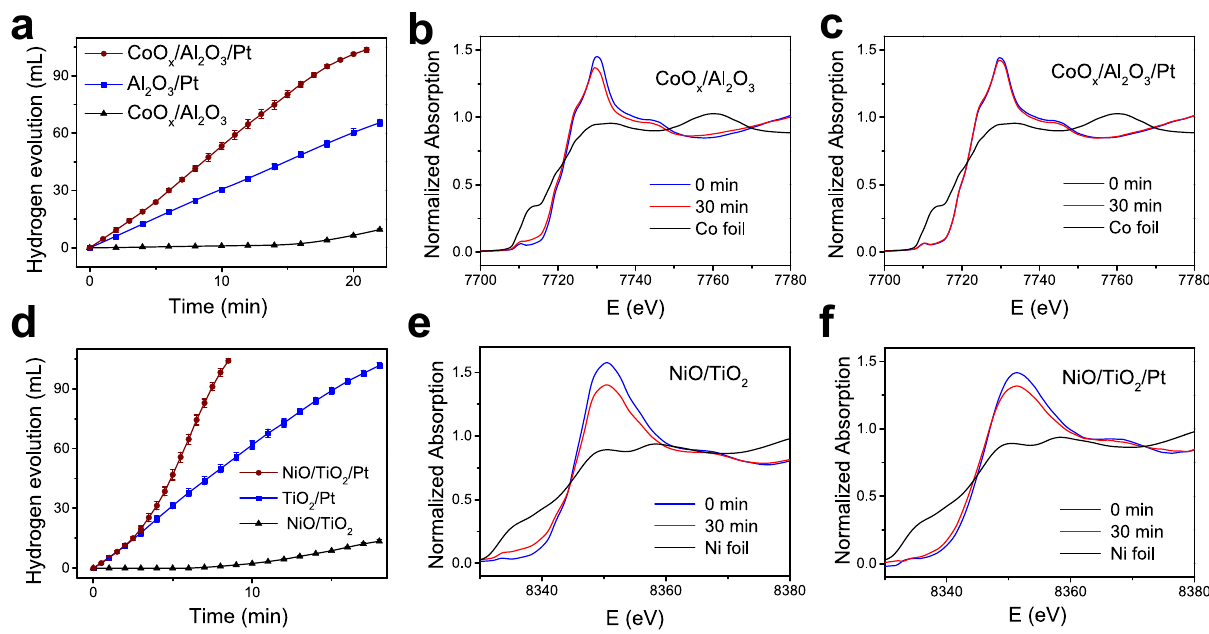
Fig. 4 Reverse spillover effects in AB hydrolysis catalyzed by the CoO x /Al 2 O 3 /Pt and NiO/TiO 2 /Pt catalysts. a Volume of H 2 generated from AB solution at 25 °C catalyzed by CoO x /Al 2 O 3 , Al 2 O 3 /Pt, and CoO x /Al 2 O 3 /Pt. In situ Co K-edge XANES spectra for b CoO x /Al 2 O 3 and c CoO x /Al 2 O 3 /Pt catalysts before reaction and after reaction for 30 min and the spectrum for Co foil. d Volume of H 2 generated from AB solution at 25 °C catalyzed by NiO/ TiO 2 , TiO 2 /Pt, and NiO/TiO 2 /Pt. In situ Ni K-edge XANES spectra for e NiO/TiO 2 and f NiO/TiO 2 /Pt catalysts before reaction and after reaction for 30 min and the spectrum obtained for Ni foil. Error bars correspond to the standard deviation for three independent